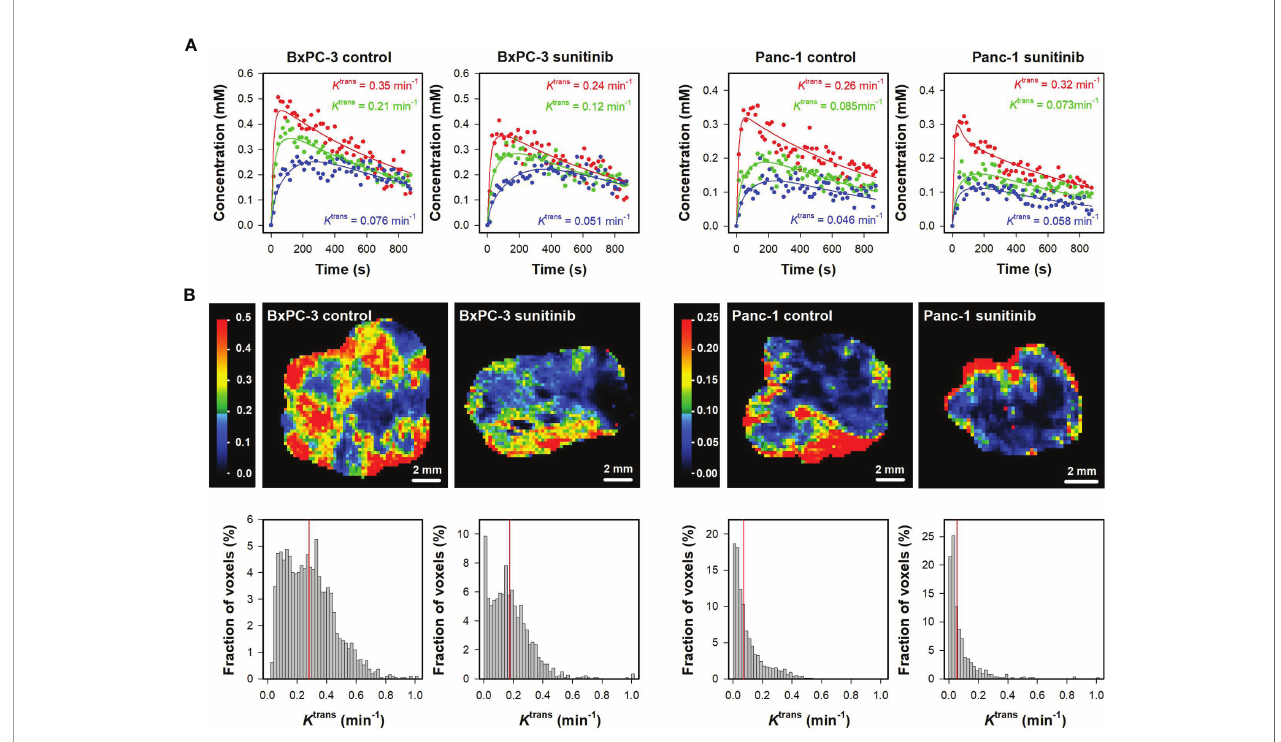
FIGURE 1 | (A) Plots of Gd-DOTA concentration versus time and the corresponding pharmacokinetic model fi ts for individual voxels in representative untreated and sunitinib-treated BxPC-3 tumors and representative untreated and sunitinib-treated Panc-1 tumors. The K trans values of the voxels are labeled in the panels. (B) K trans maps and histograms of the representative untreated and sunitinib-treated BxPC-3 tumors and the representative untreated and sunitinib-treated Panc-1 tumors. K trans scales are given by the color bars, and median K trans values are indicated by red vertical lines in the K trans histograms.